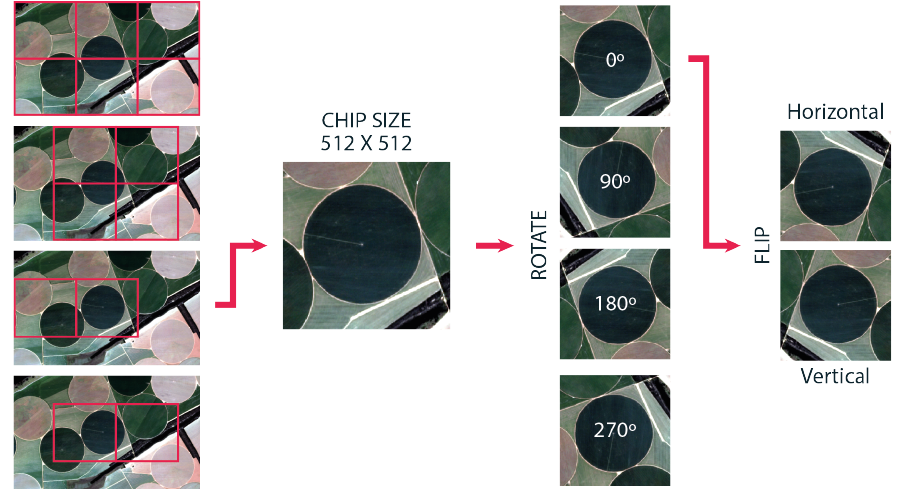
Figure 4. Data augmentation process. For each training image, we extracted 512 × 512 patches with a step size of 256 pixels. We rotated each patch by 90, 180, and 270 degrees, increasing the amount of available data by four times. Finally, we flipped all patches, including the ones produced by rotation, horizontally and vertically. In total, our data augmentation strategy increased the amount of training samples by 48